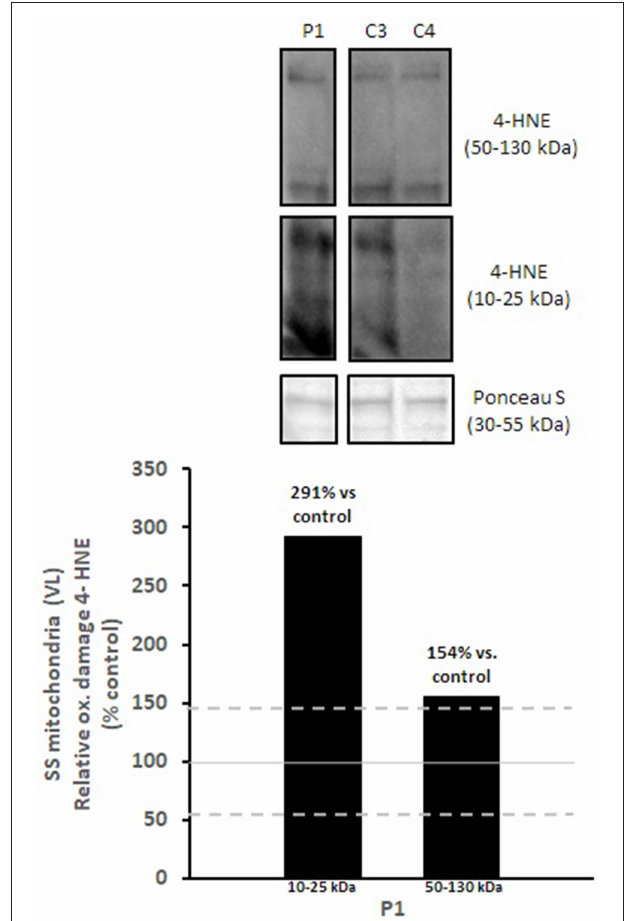
FIGURE 4 | Oxidative damage of subsarcolemmal mitochondria in vastus lateralis muscle. 4-HNE levels of subsarcolemmal mitochondria isolated from vastus lateralis were normalized to total protein (Ponceau S) and presented as a percentage of healthy, gender, and age-matched controls ( N = 2). Solid gray line indicates normal 4-HNE levels (e.g., control mean is 100%) and dashed lines are bidirectional standard errors calculated from the absolute values, control mean, and N . The samples are not biological replicates per se since each lane is a unique subject, and the standard error of the mean for the healthy controls is what is reflected in the lines to use as a comparison to the